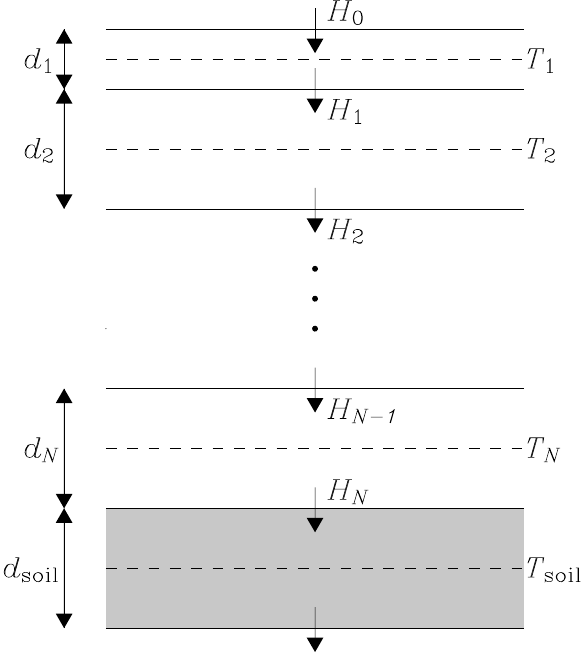
Fig. 4. Structure of the numerical discretisation over the layers for the temperatures and heat fluxes within the multi-level snow scheme in